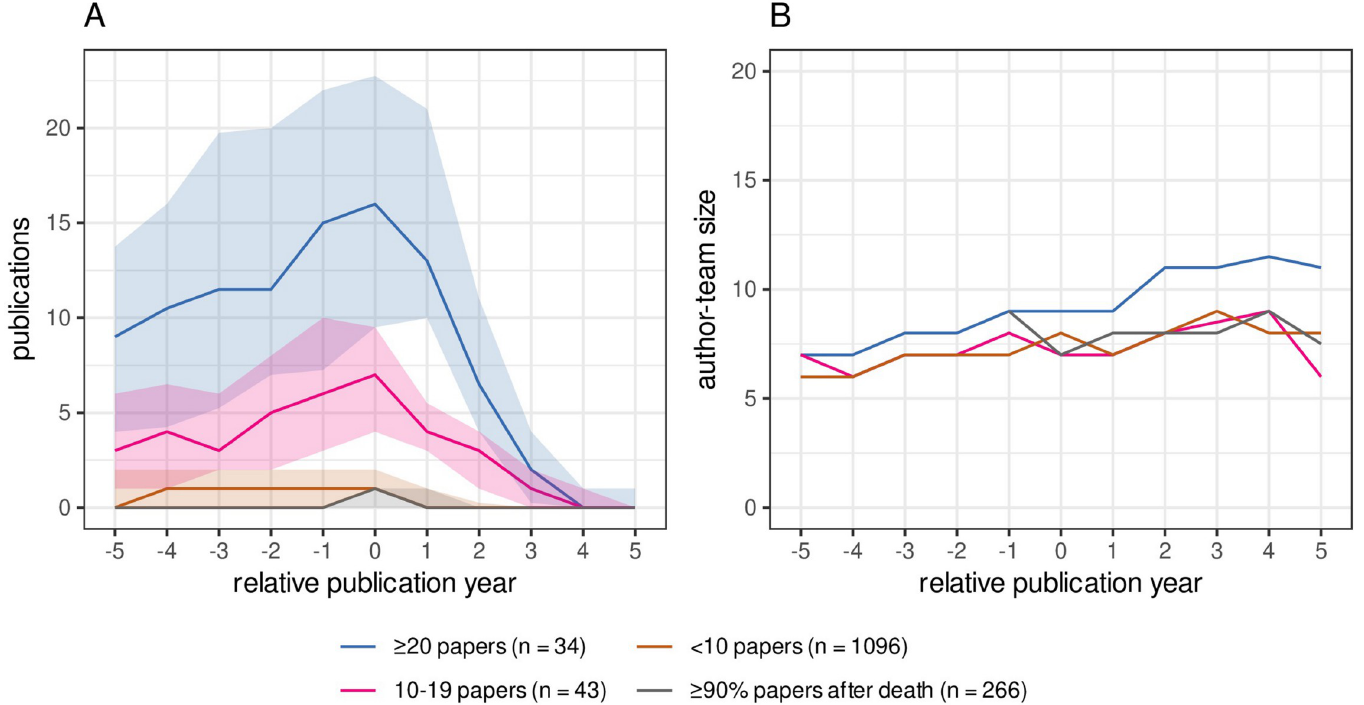
Fig 4. Trend of publication counts around the year of death. (A) The number of publications (y axis) by deceased authors by deceased author publication groupings over an 11-year time span encompassing 5 years before death to 5 years after year of death (x axis). The lines represent the median, and the shaded area represents the interquartile range. (B) Author-team size of publications by deceased authors. The number of co-authors for each publication with a deceased author was calculated and depicted over an 11-year span. Lines represent the median of the author-team size of publications within 5 years before and after the year of death and the shades represent the interquartile range. Colors depict four different groupings of deceased authors based on the number of their deceased publications ranging from those with � 20 such publications (orange) and those with � 90% of their total publications after death (grey).